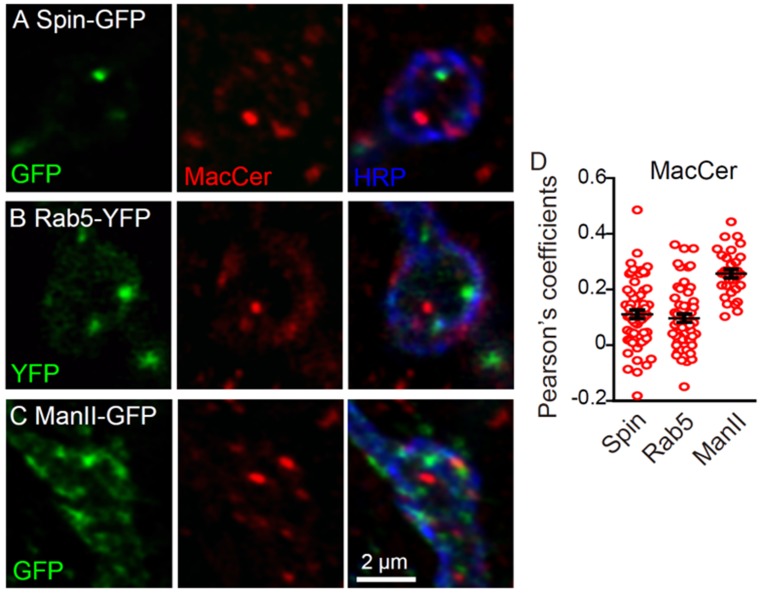
MacCer puncta showed few overlap with Rab5-YFP, Spinster-GFP and Mannose II-GFP.Single sections of NMJ4 boutons triple-labeled with anti-MacCer (red), anti-HRP (blue), and specific organelle markers (green) in nSyb-Gal4/UAS-Spin-GFP (A), UAS-YFP-Rab5/+; nSyb-Gal4/+ (B), and nSyb-Gal4/UAS-ManII-GFP (C) larvae. MacCer puncta showed few overlaps with these organelles in NMJ boutons. Images were processed by deconvolution. Scale bar: 2 μm. (D) Pearson’s coefficients of colocalization between MacCer and indicated proteins. n = 61/9, 57/8, and 30/5 (from left to right, boutons/animals).